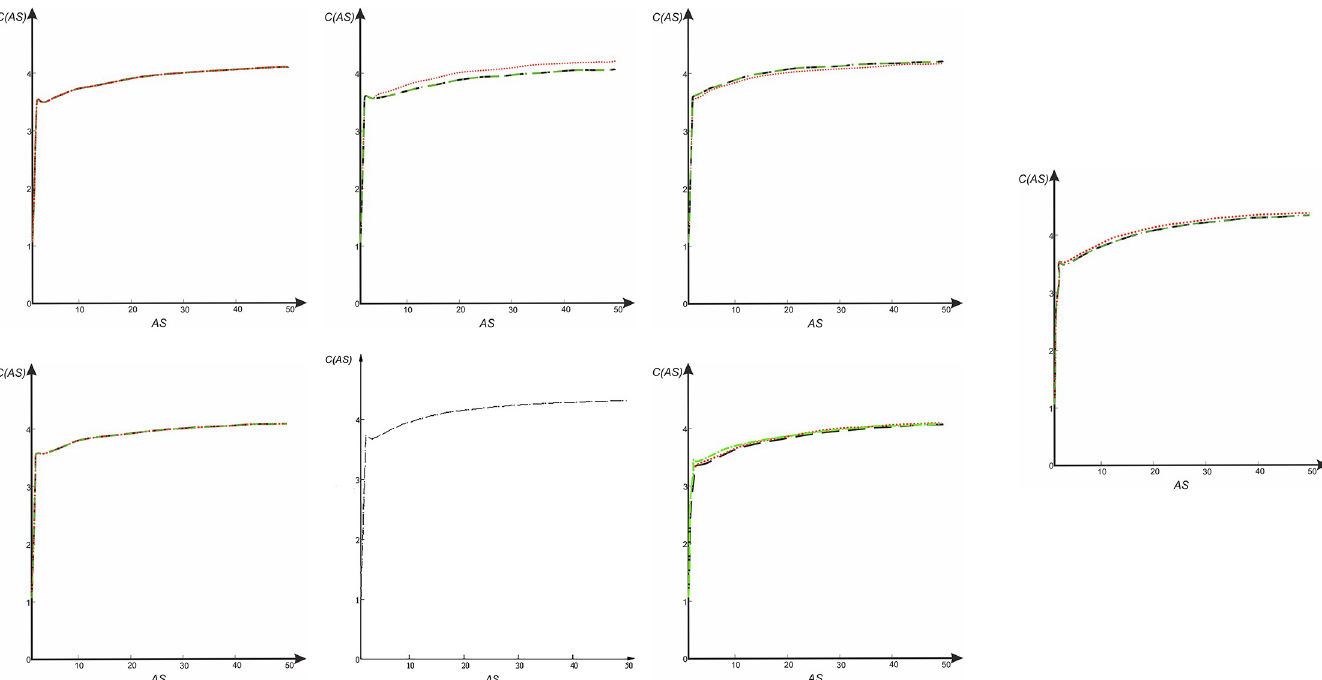
Fig 3. Dependence of contrast C of s-LASCA images of GB-speckles on parameter AS . E/Bour, ST94—dot lines (in red color), G/9301, ST 95 –dashed lines (in black color), G/11222, ST94 –dash-dotted lines (in green color). (a) gatA . (b) gidA . (c) enoA . (d) fumC . (e) hemN . (f) hflX . (g) oppA .